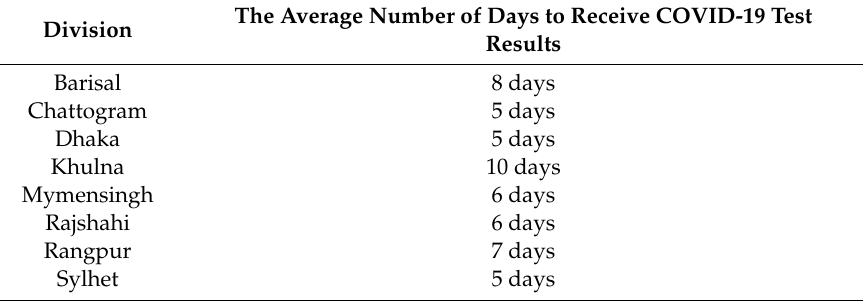
Table 3. The average duration of COVID-19 test results in eight different divisions.